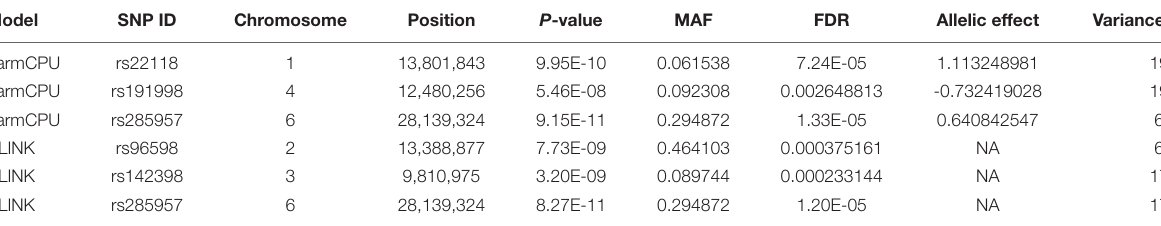
TABLE 4 | A summary of significant SNPs consistently associated with gummosis disease in peach accessions. Model